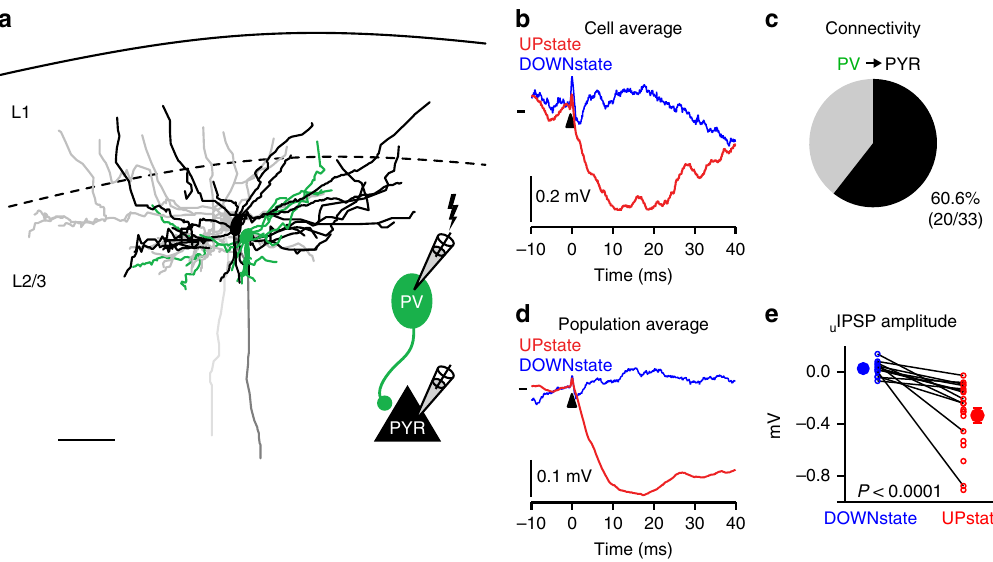
Fig. 6 In vivo monosynaptic inhibitory connectivity from parvalbumin-expressing neurons to excitatory pyramidal neurons. a Reconstruction of an example L2/3 triple recording containing two PYR neurons (black and gray) and one PV neuron (green). Inset: schematic showing stimulation of PV neurons to identify monosynaptic inputs to PYR neurons. Scale bar, 50 µ m. b Example u IPSP in a PYR neuron evoked by single evoked AP in a PV neuron (time of PV neuron AP = 0 ms). V m mark shows − 56.9 mV. c Probability of fi nding monosynaptic connections from PV to PYR neurons (PV-PYR, black). d Population average of u IPSP (DOWNstate, n = 13 connections; UPstate, n = 20 connections) during periods of UPstate (red) and DOWNstate (blue). V m mark shows UPstate − 49.0 mV, DOWNstate − 65.1 mV. e u IPSPs increase in amplitude as PYR neurons go from DOWNstate to UPstate. Open circles represent inhibitory connections, lines show connections tested both in DOWNstate and UPstate, fi lled circles with error bars shows mean ±